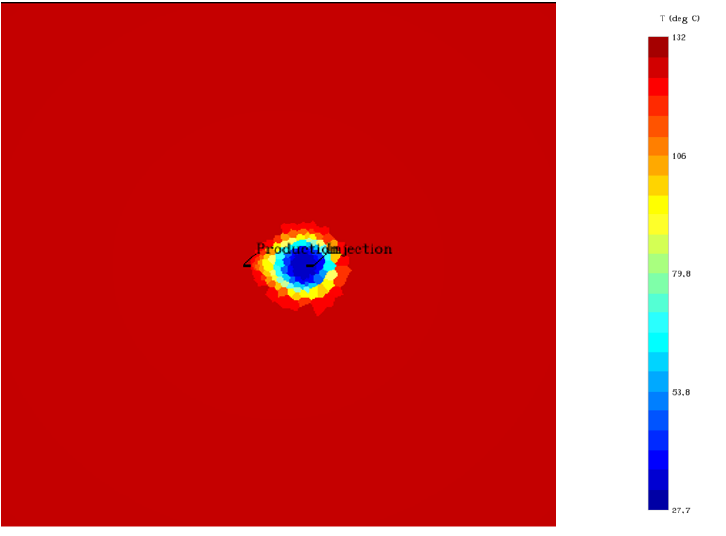
Figure 20. Model simulation of well doublet temperature distribution after 30 years of production—post-rift phase.